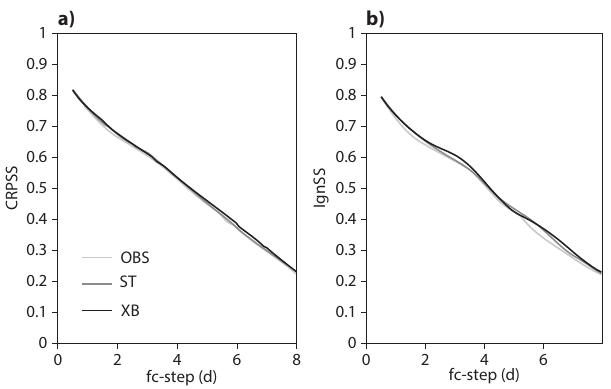
Figure 12. Average CRPSS (a) and ignorance score (b) of EPS run with EDA-only perturbations generated from OBS-EDA (light grey), ST-EDA (dark grey) and XB-EDA (black) for temperature at 850hPa over the Southern Hemisphere. The average has been computed considering 18 cases, 51-member EPS forecast with ini- tial condition from 12 to 14 November 2008, every other day (12:00UTC